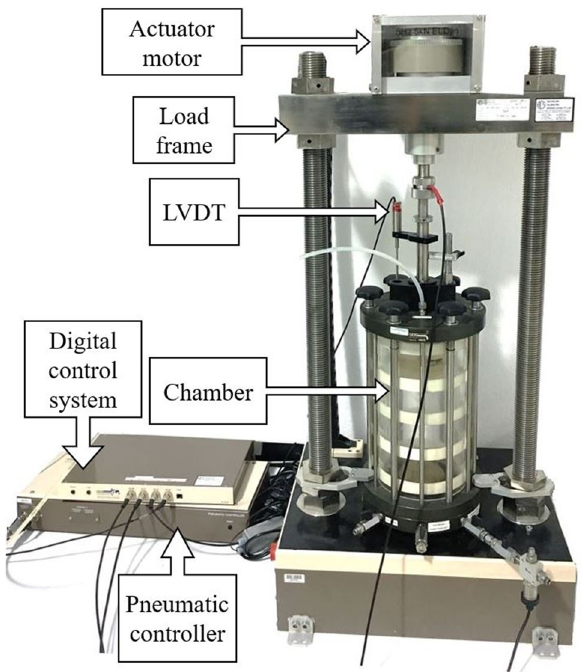
Fig. 4 Repeated-load triaxial